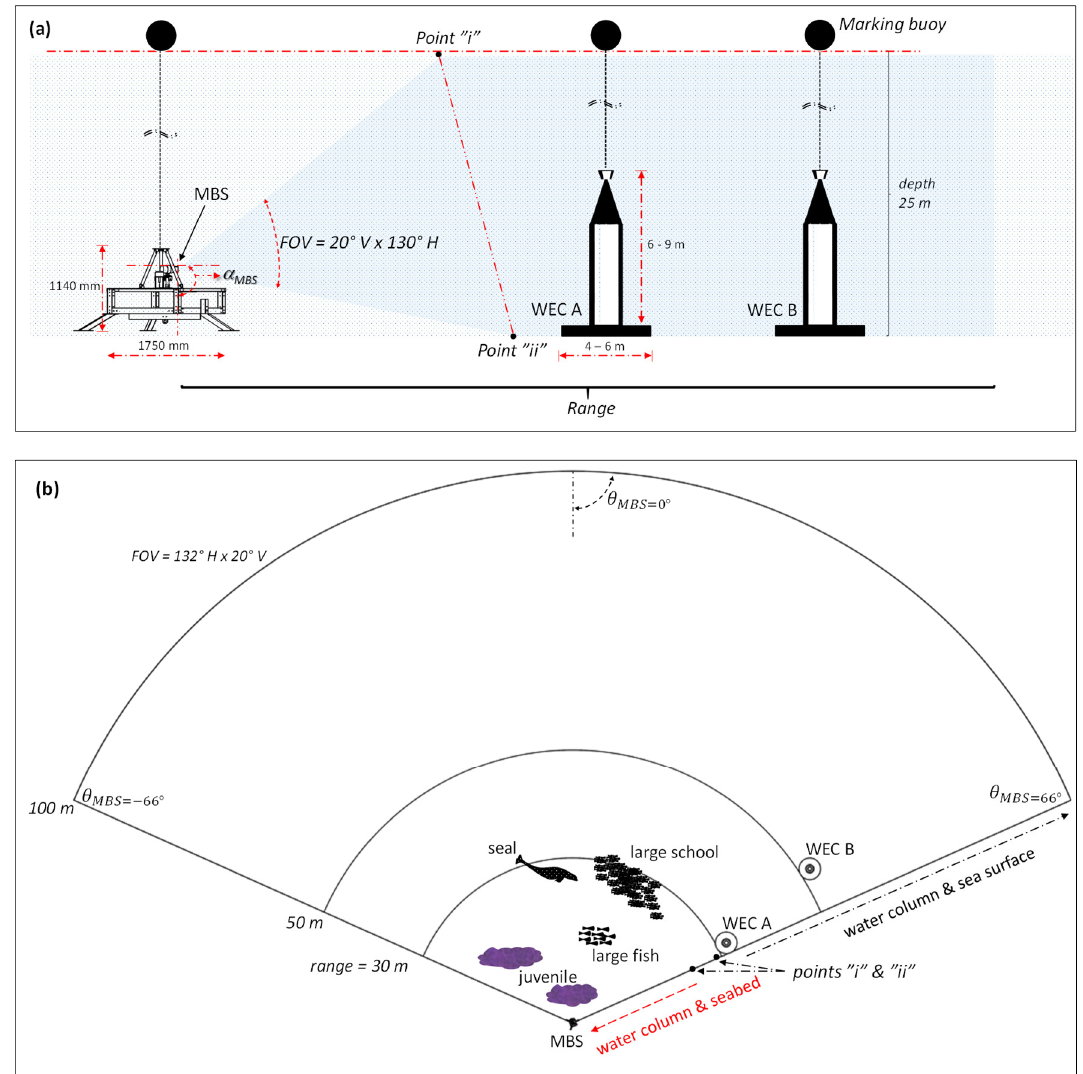
Figure 1. ( a ) Lateral and ( b ) top view-scheme of the acoustic images acquired by the multibeam sonar (MBS) at distances of 30 m and 50 m from WECs A and B, respectively. The field of view (FOV) had a width of 82 m or 130 ◦ ( θ MBS = − 66 ◦ to +66 ◦ ), height of 20 ◦ and maximum range of 100 m, the MBS pitch angle ( α MBS ) was set to 10 ◦.